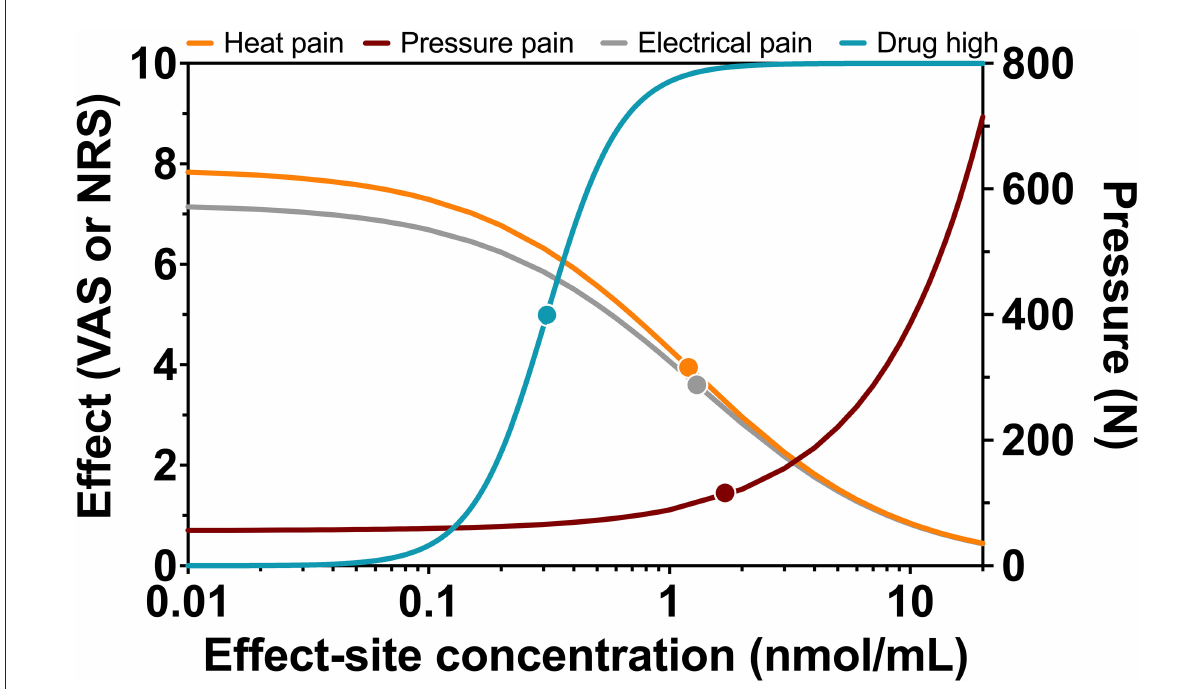
FIGURE6 Steady-state concentration-effect relationships for heat pain, pressure pain, electrical pain, and drug high. Relationship between steady-state or effect-site S- ketamine plasma concentrations and effect with dots representing C 50 values or half-effect concentration